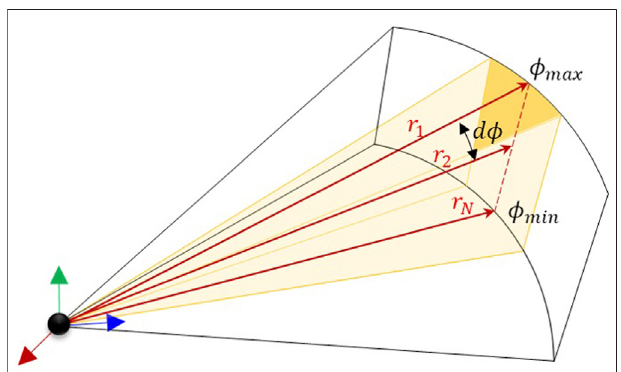
FIGURE 1 | A single sonar beam with its azimuth and elevation beam widths.